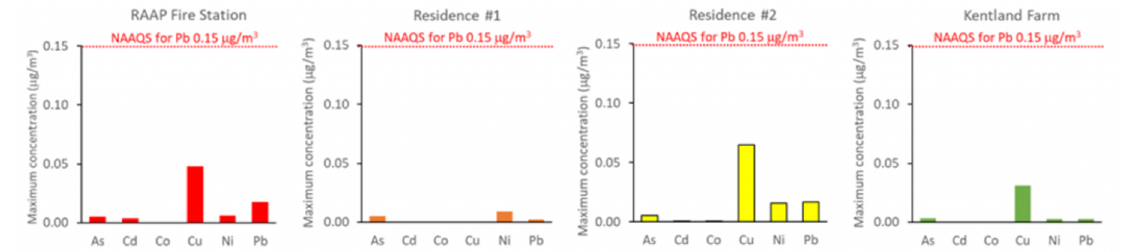
Figure 4. Maximum observed airborne concentrations of arsenic (As), cadmium (Cd), cobalt (Co), copper (Cu), nickel (Ni), and lead (Pb). Observed levels of all five elements were well below 0.15 μg/m 3 (indicated by a red line), which is the standard for lead, which has the most stringent air quality or workplace standard of the five elements.